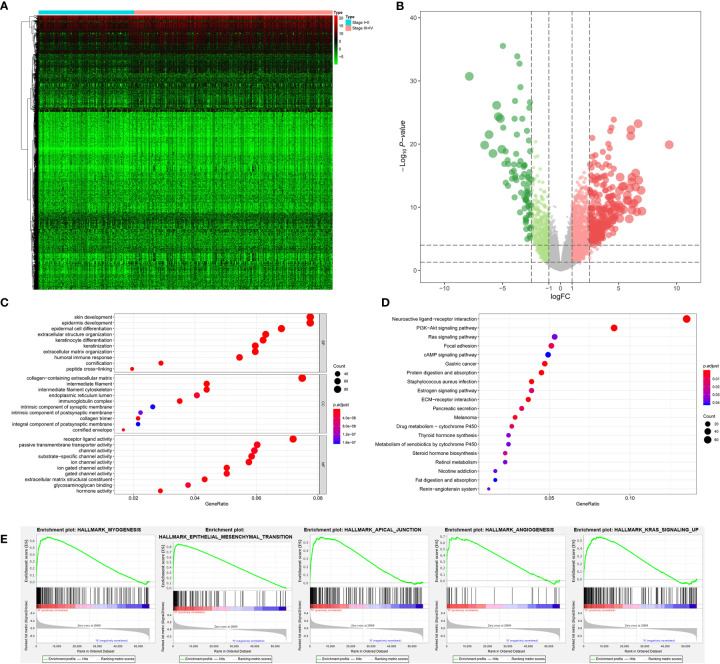
The results of differential expression genes analysis and functional enrichment analysis between Stage I or II BLCAs and Stage III or IV BLCAs: The heatmap (A) and volcano plot (B) of the differential expressed genes. The GO (C), KEGG (D), and (E) top five GSEA enriched terms for the differential expressed genes.